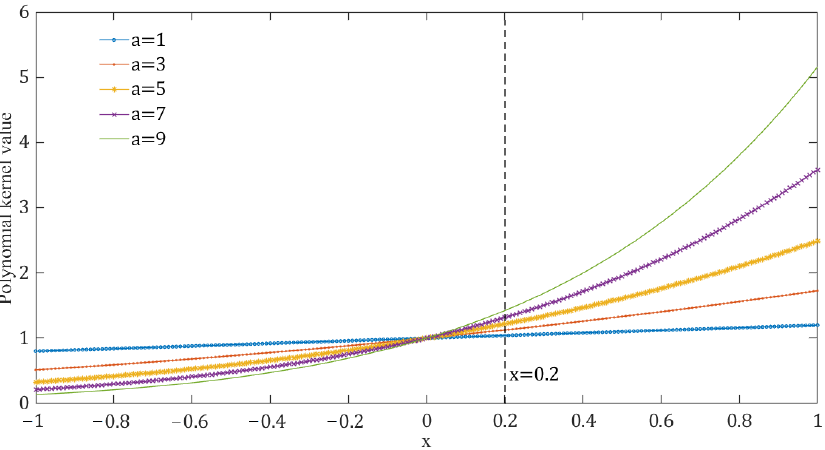
Figure 1. Data distribution of polynomial kernel (test point x = 0.2).